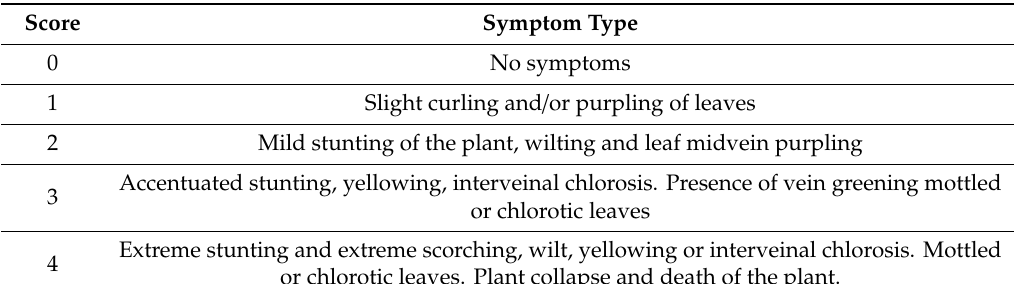
Table 1. Rating scale of disease severity on